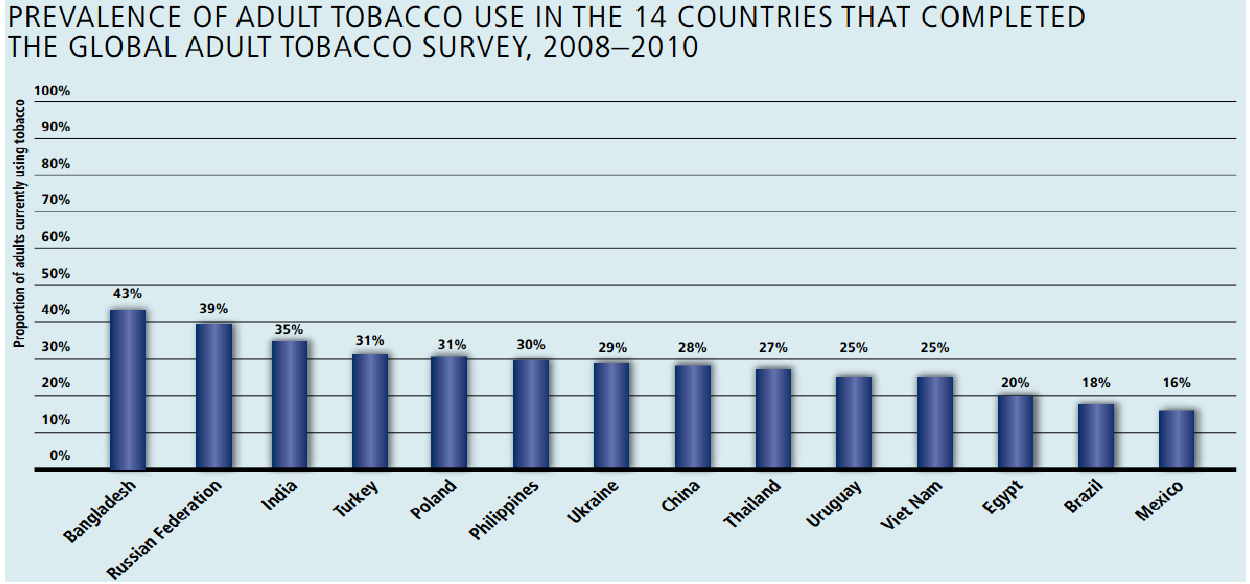
Figure 2. Tobacco prevalence in 14 countries that completed GATS